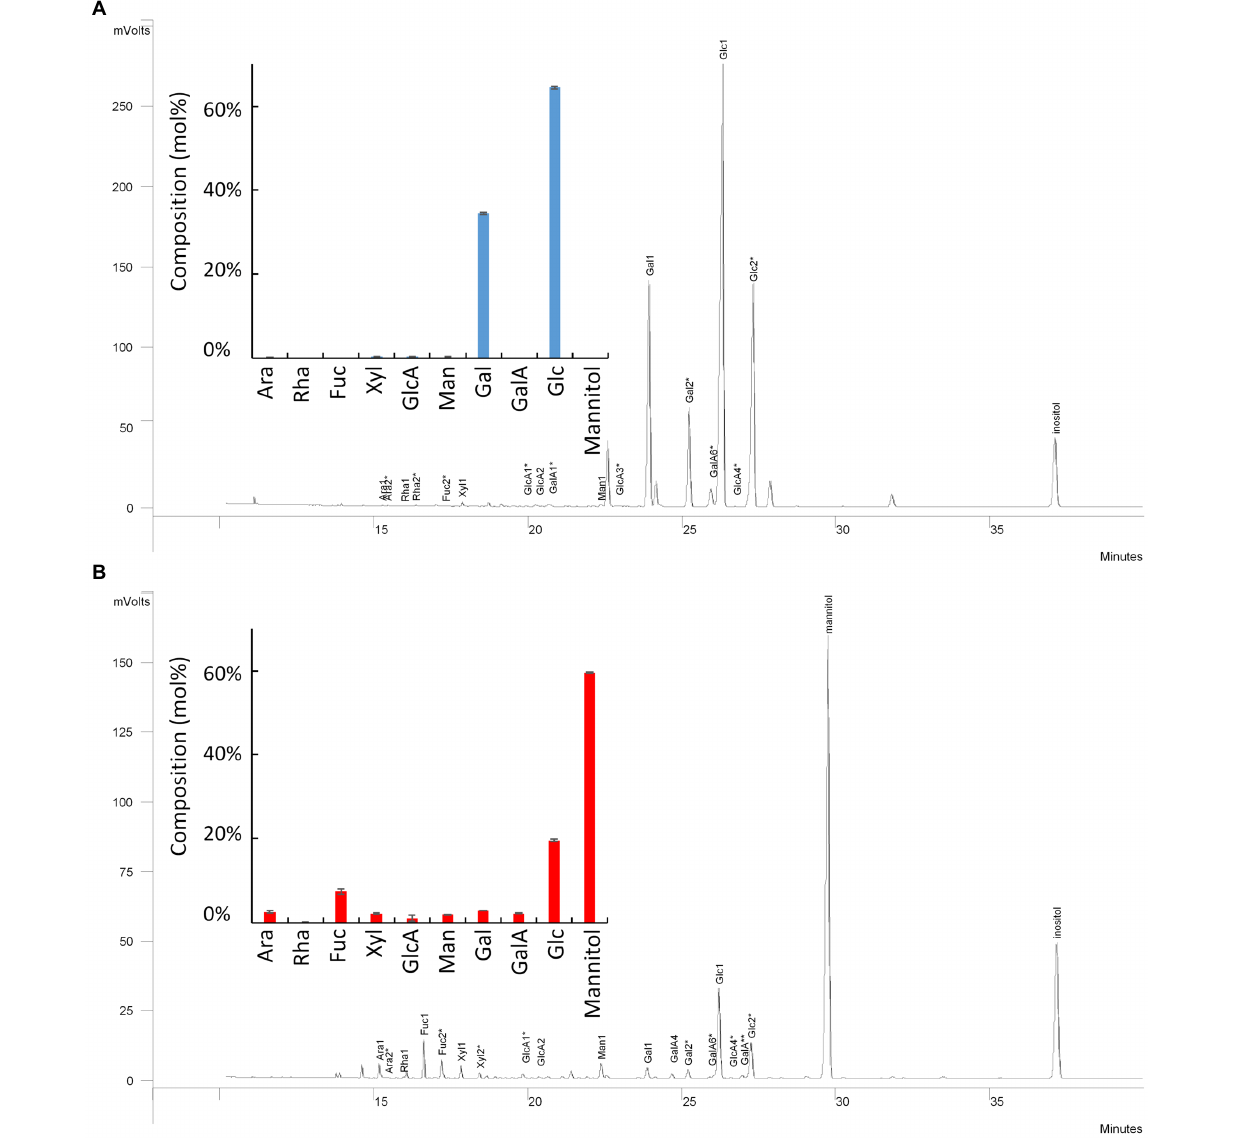
FIGURE 1 | Monosaccharide composition of the two carbohydrate-based active ingredients: Active ingredients 1 ( A , blue bars) and 2 ( B , red bars). Ara, arabinose; Rha, rhamnose; Fuc, fucose; Xyl, xylose; GlcA, glucuronic acid; Man, mannose; Gal, galactose; GalA, galacturonic acid; Glc, glucose. Data are mean of three